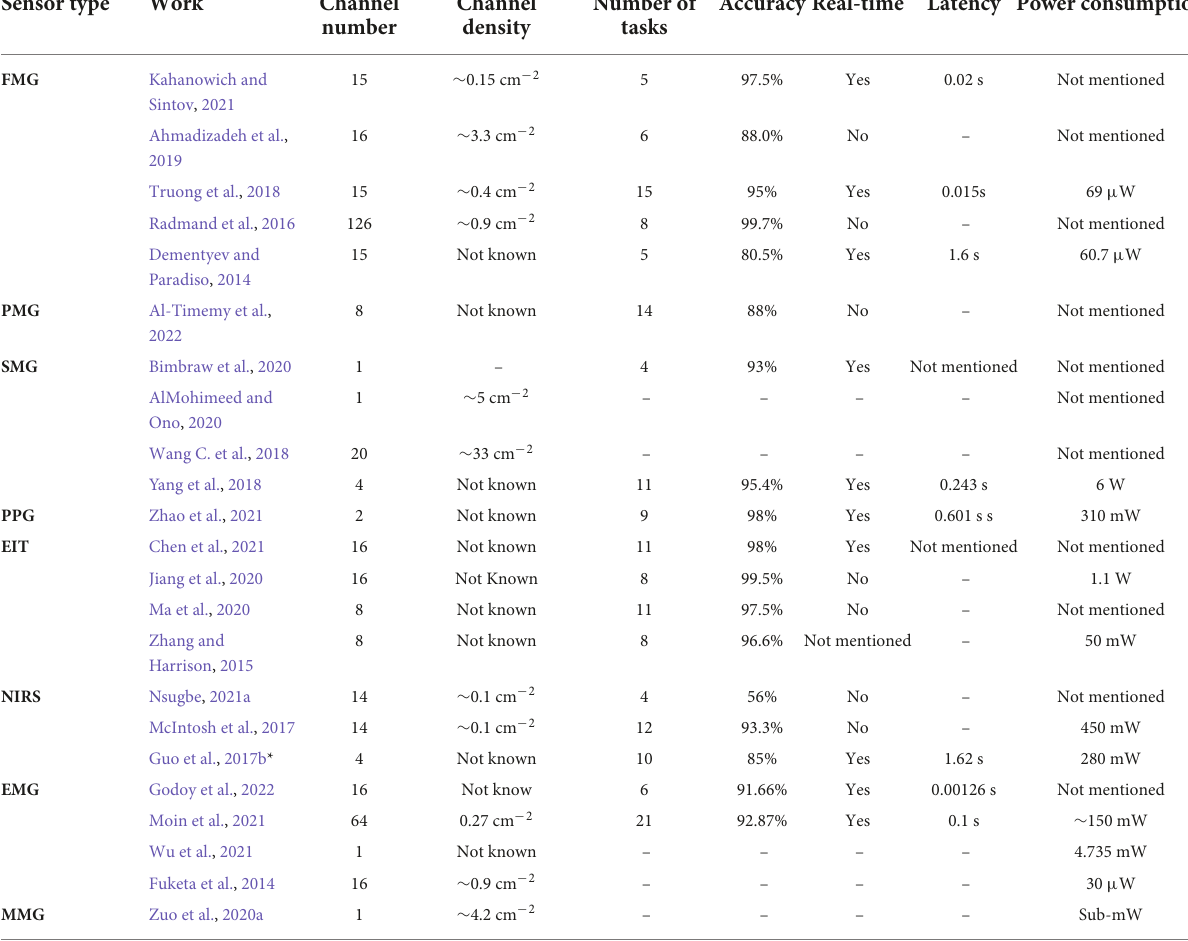
TABLE 1 Recent typical works of each sensing technology and their